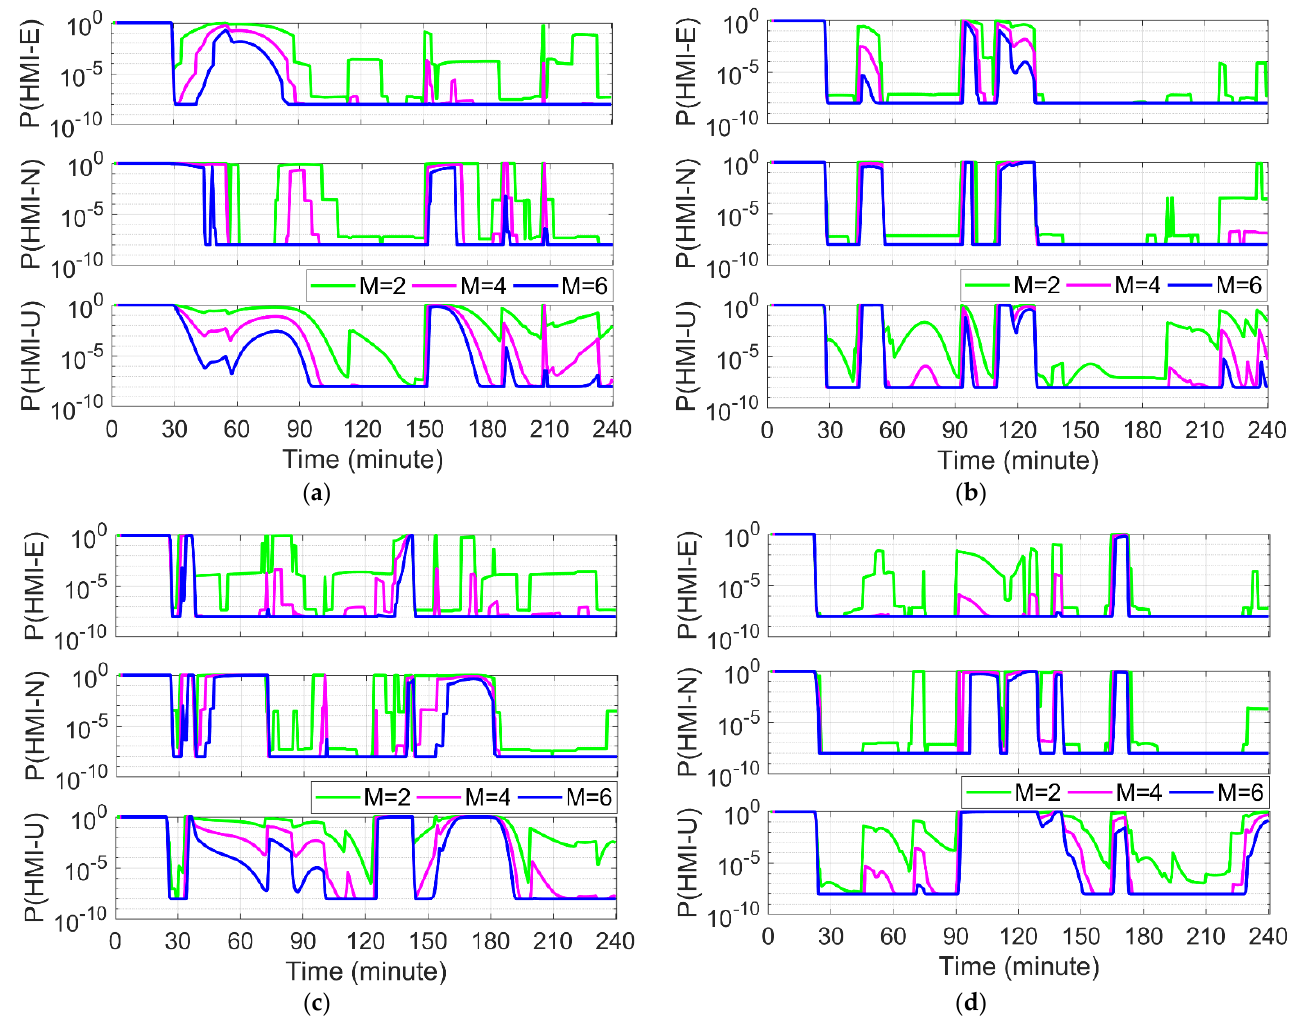
Figure 11. The integrity risk of the: ( a ) BREW station; ( b ) FAIR station; ( c ) HUEG station; and ( d ) DAV1 station. The top, middle and bottom panels of each figure represent the east (E), north (N) and up (U) directions. Different colors represent time windows of different lengths, respectively.